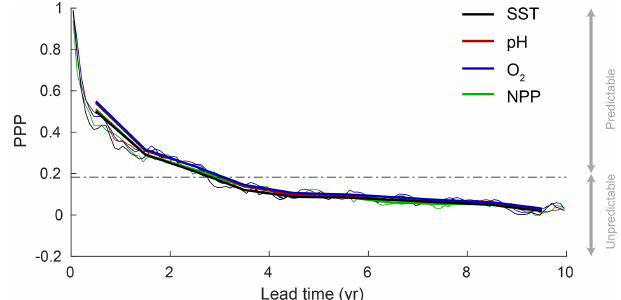
Figure 2. Globally averaged prognostic potential predictability (PPP) for all four marine ecosystem drivers at the surface, except for NPP which is integrated over the top 100m. Monthly mean (thin lines) and annual mean (thick lines) values of PPP are shown. The horizontal black dashed line represents the predictability threshold. If PPP is above (below) the predictability threshold, the driver is po- tentially predictable (unpredictable) as indicated with the arrows on the right-hand side. The PPP has first been calculated at each grid cell and then averaged